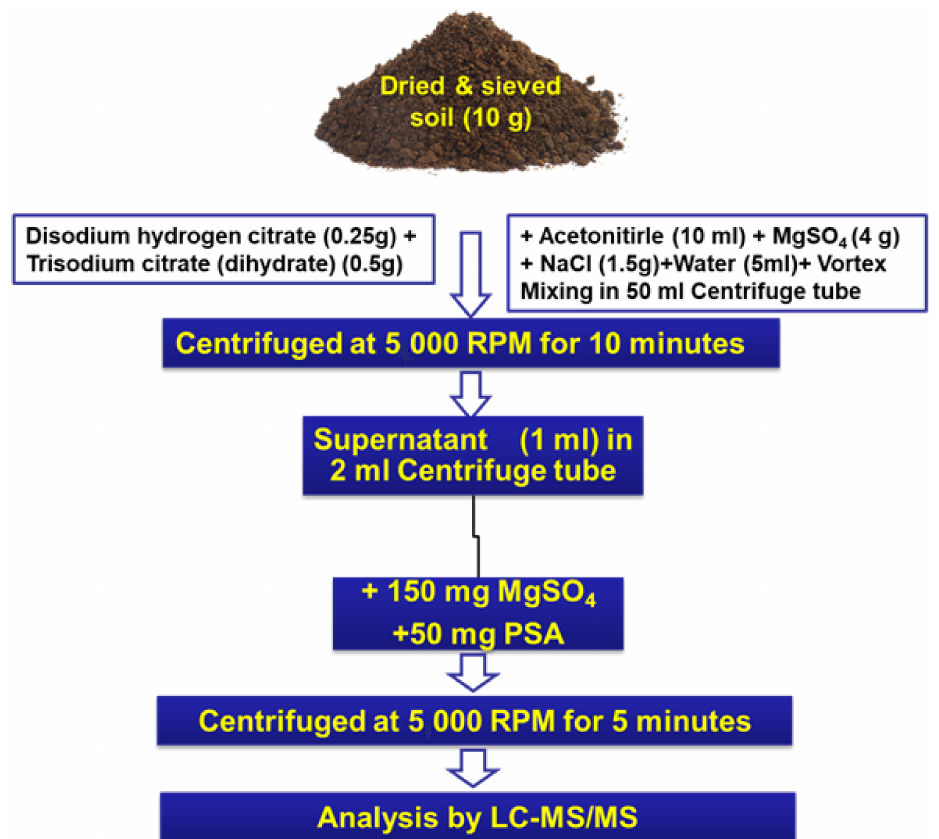
Figure 2. Procedure of sample preparation for herbicide residue.